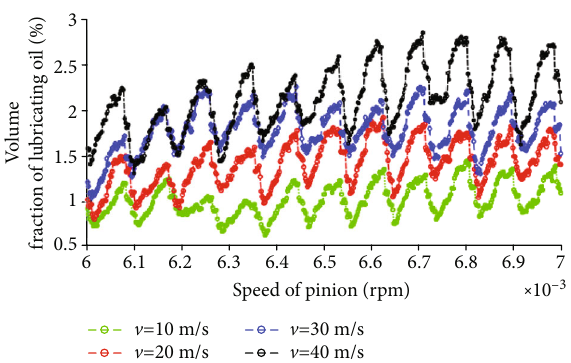
Figure 12: Oil volume fraction versus oil-jet velocities.